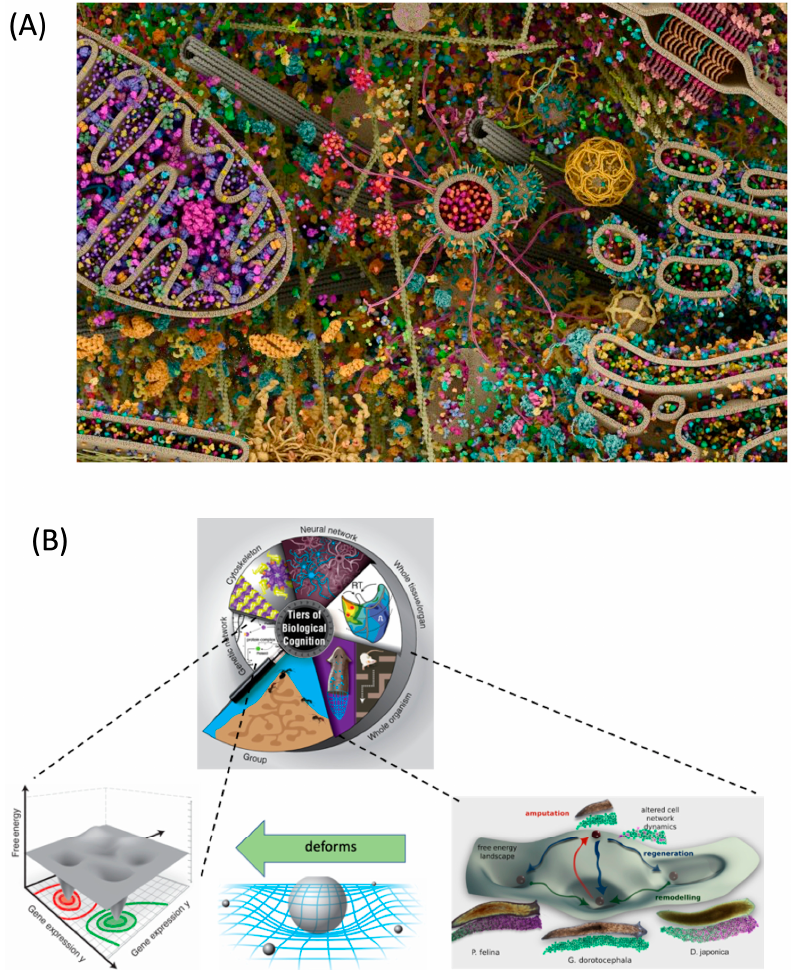
Figure 3. Polycomputing architectures in biology. ( A ) 3D computer rendering of a eukaryotic cell modeled using X-ray, nuclear magnetic resonance (NMR), and cryo-electron microscopy datasets for all its molecular actors. The image was created by Evan Ingersoll and Gaël McGill (Digizyme Inc.) and illustrates the pressure on biology to have each component perform multiple duties (there is not much room to add additional components); this image shows a dilute cytoplasm relative to a real